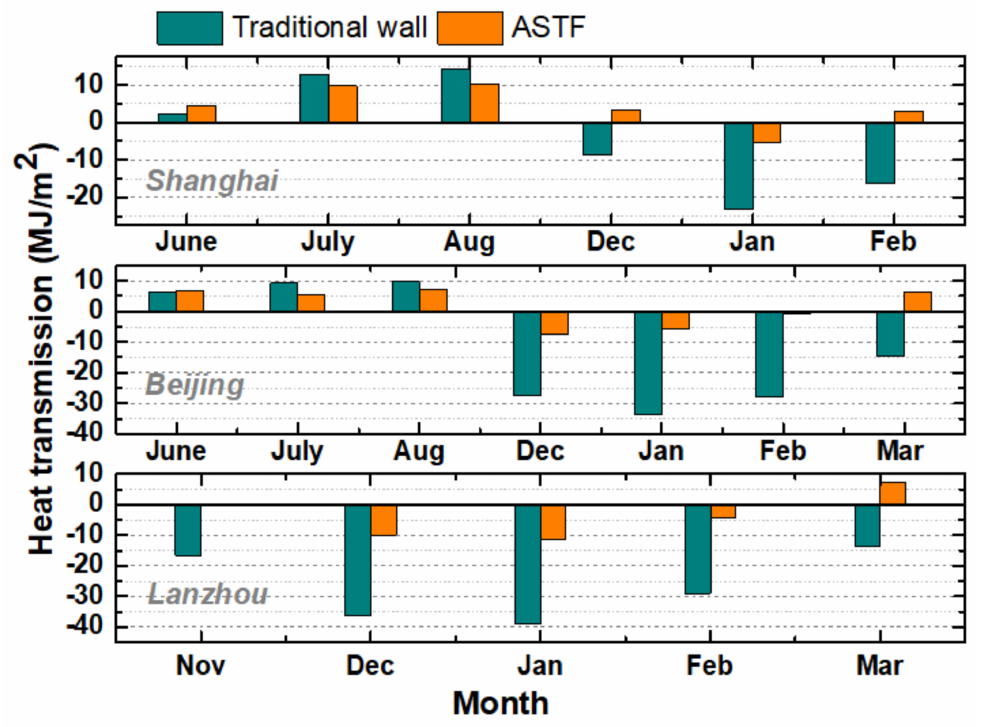
Figure 8. Heat transmission load of the ASTF in three typical cities.